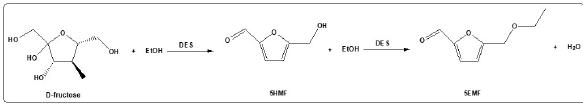
Figure 10: DES catalysed synthesis of 5-EMF.